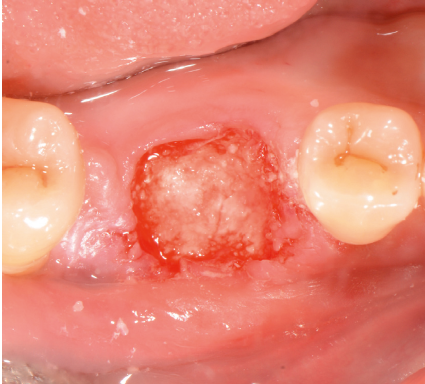
Figure 3: Grafting of the site with the in situ hardening synthetic bone substitute. Attention was given not to overfill the socket.